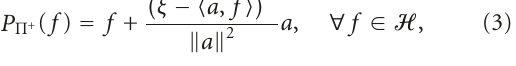
Figure 1: An illustration of the metric projection mapping P C onto the closed convex subset C of H , the projection P B [ f closed ball B [ f 0 , δ ], the orthogonal projection P M onto the closed linear subspace M , and the oblique projection P M , M (cid:14) on M along the closed linear subspace M (cid:14)